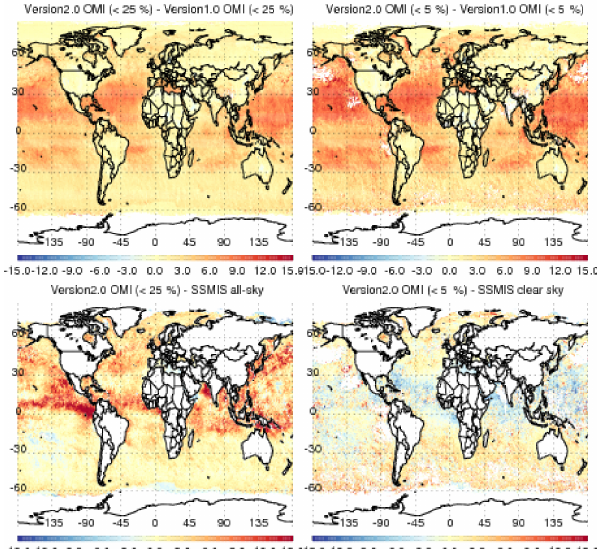
Figure 11. Top row: monthly mean of version 2.0 OMI − version 1.0 OMI for cloud fraction (left) < 25% and (right) < 5% for July 2005. Bottom left: monthly mean of version 2.0 OMI with cloud fraction < 25% − all sky SSMIS for July 2005. Bottom right: monthly mean of version 2.0 OMI with cloud fraction < 5% − “clear” sky SSMIS for July 2005.